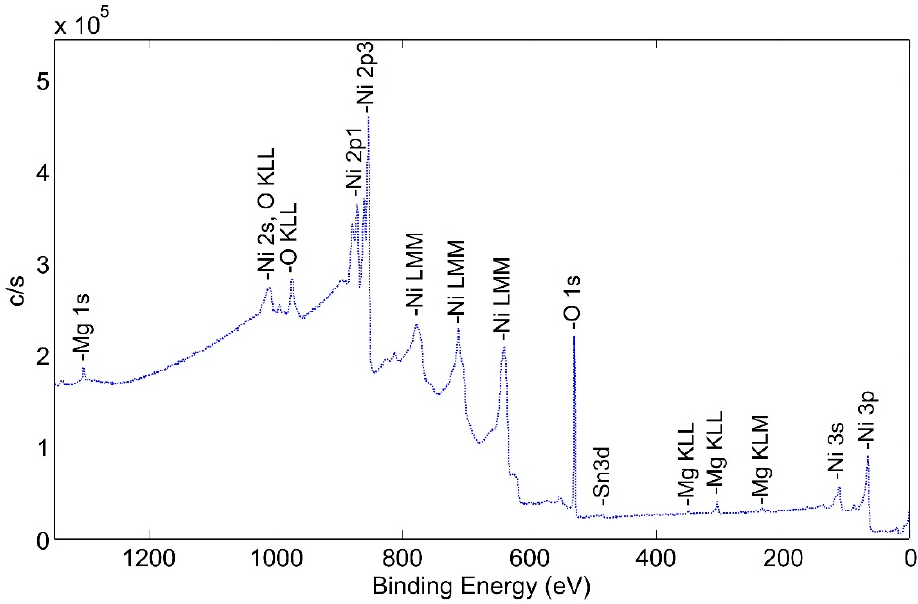
Figure 10. Wide Scan Photoemission Spectra for Surface of Pretreated and Activated NPG d-sample. The height of the oxygen peaks is slightly lower than for the pretreated sample. In addition, small peaks corresponding to magnesium and tin are observed. Although tin